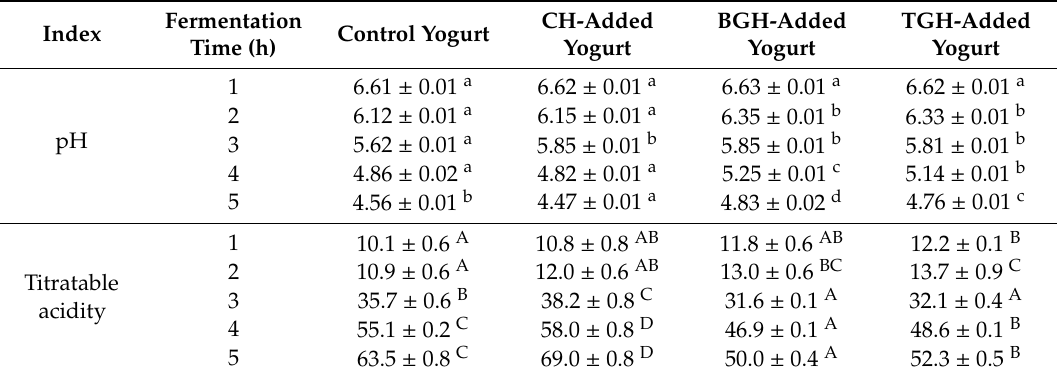
Table 1. The values of pH and titratable acidity of the four yogurt samples during a fermentation period of 1 − 5